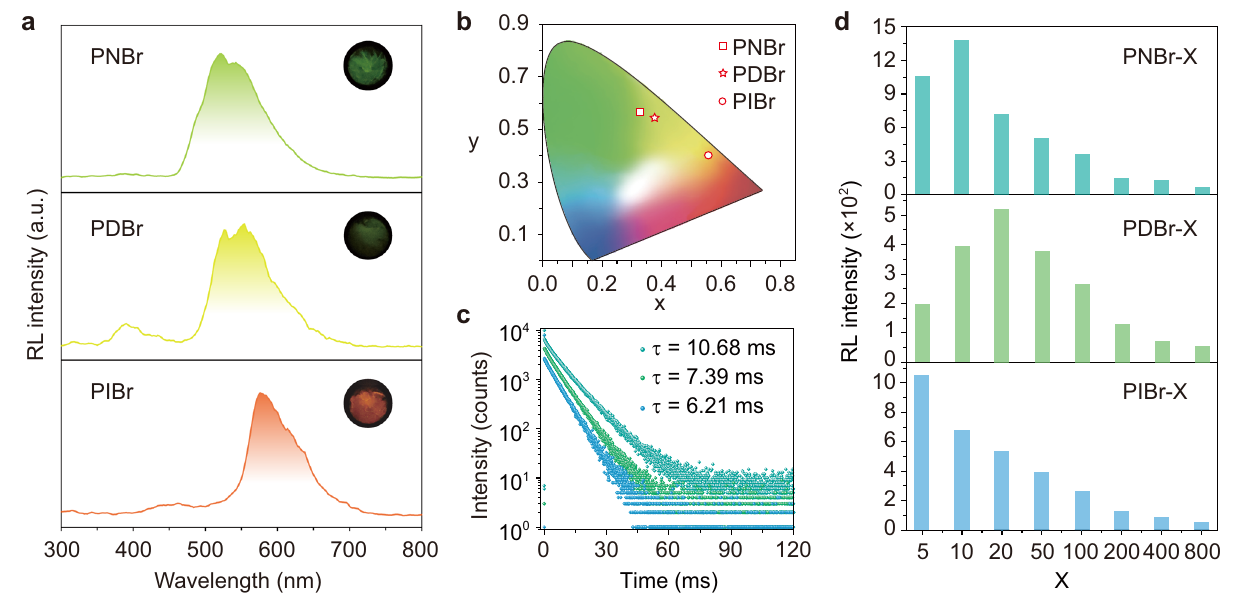
Fig. 4 Colorful phosphorescent radioluminescence in organic copolymers under X-ray irradiation. a Normalized radioluminescence spectra and the related photographs of PNBr, PDBr, and PIBr copolymer fi lms under the irradiation of a dose rate of 278 μ Gys − 1 , respectively. b CIE chromaticity coordinate diagram of the radioluminescence color of the copolymers. c Lifetime decay curves of emission bands at 546, 555, and 575 nm for PNBr, PDBr, and PIBr copolymer fi lms, respectively, under UV light excitation. d Radioluminescence (RL) intensity variation of PNBr, PDBr, and PIBr copolymer fi lms with different molar feed ratios of two monomers by X-ray irradiation at a dose rate of 278 μ Gys − 1 . Note that the examination was quantitative for each from green to orange-red, and demonstrated the potential of amorphous copolymers for X-ray radiography. Our fi ndings not only reveal the X-ray-excited phosphorescence properties of